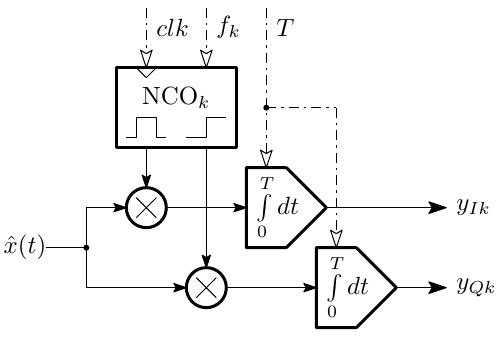
Figure 9. Harmonic projection channel block